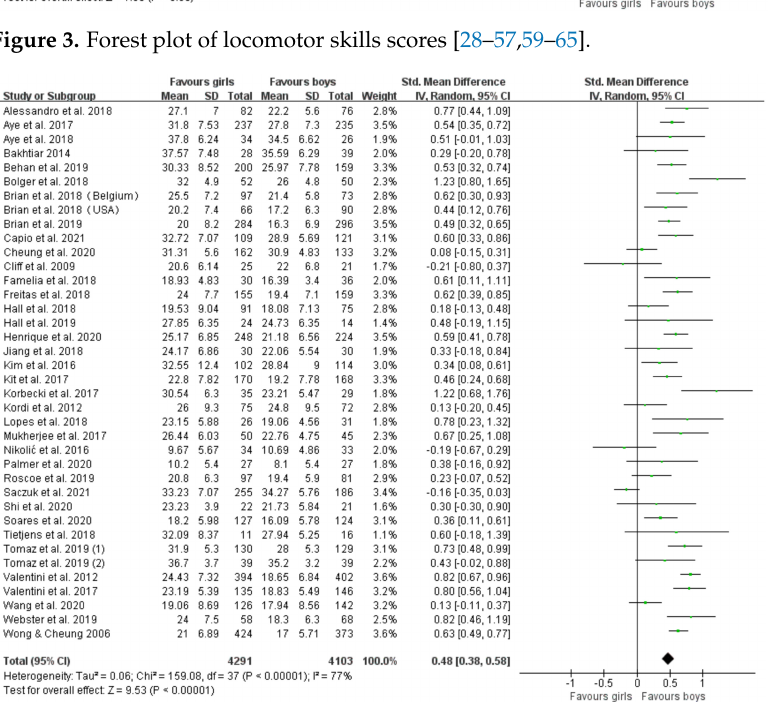
Figure 4. Forest plot of object control skills scores